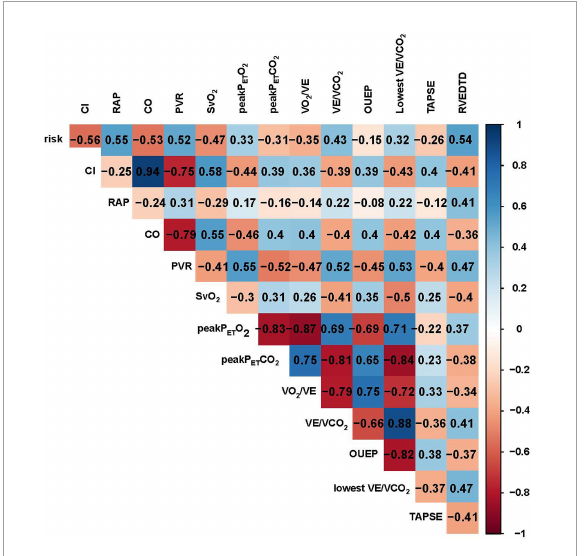
FIGURE4 Correlation analysis of demographics, CPET, hemodynamics and echocardiography in patients with IPAH. CO, cardiac output; CI, cardiac index; PVR, pulmonary vessel resistance; SvO 2 , mixed venous oxygen saturation; RAP, right atrial pressure; Peak P ET CO 2 , peak end–tidal partial pressure of CO 2 , Peak P ET O 2 , peak end–tidal partial pressure of O 2 ; VCO 2 , carbon dioxide output; VE, minute ventilation; VO 2 , oxygen uptake; RVEDTD, right ventricular end-diastolic transverse diameter; TAPSE, tricuspid annular plane systolic excursion; OUEP, oxygen uptake efficiency